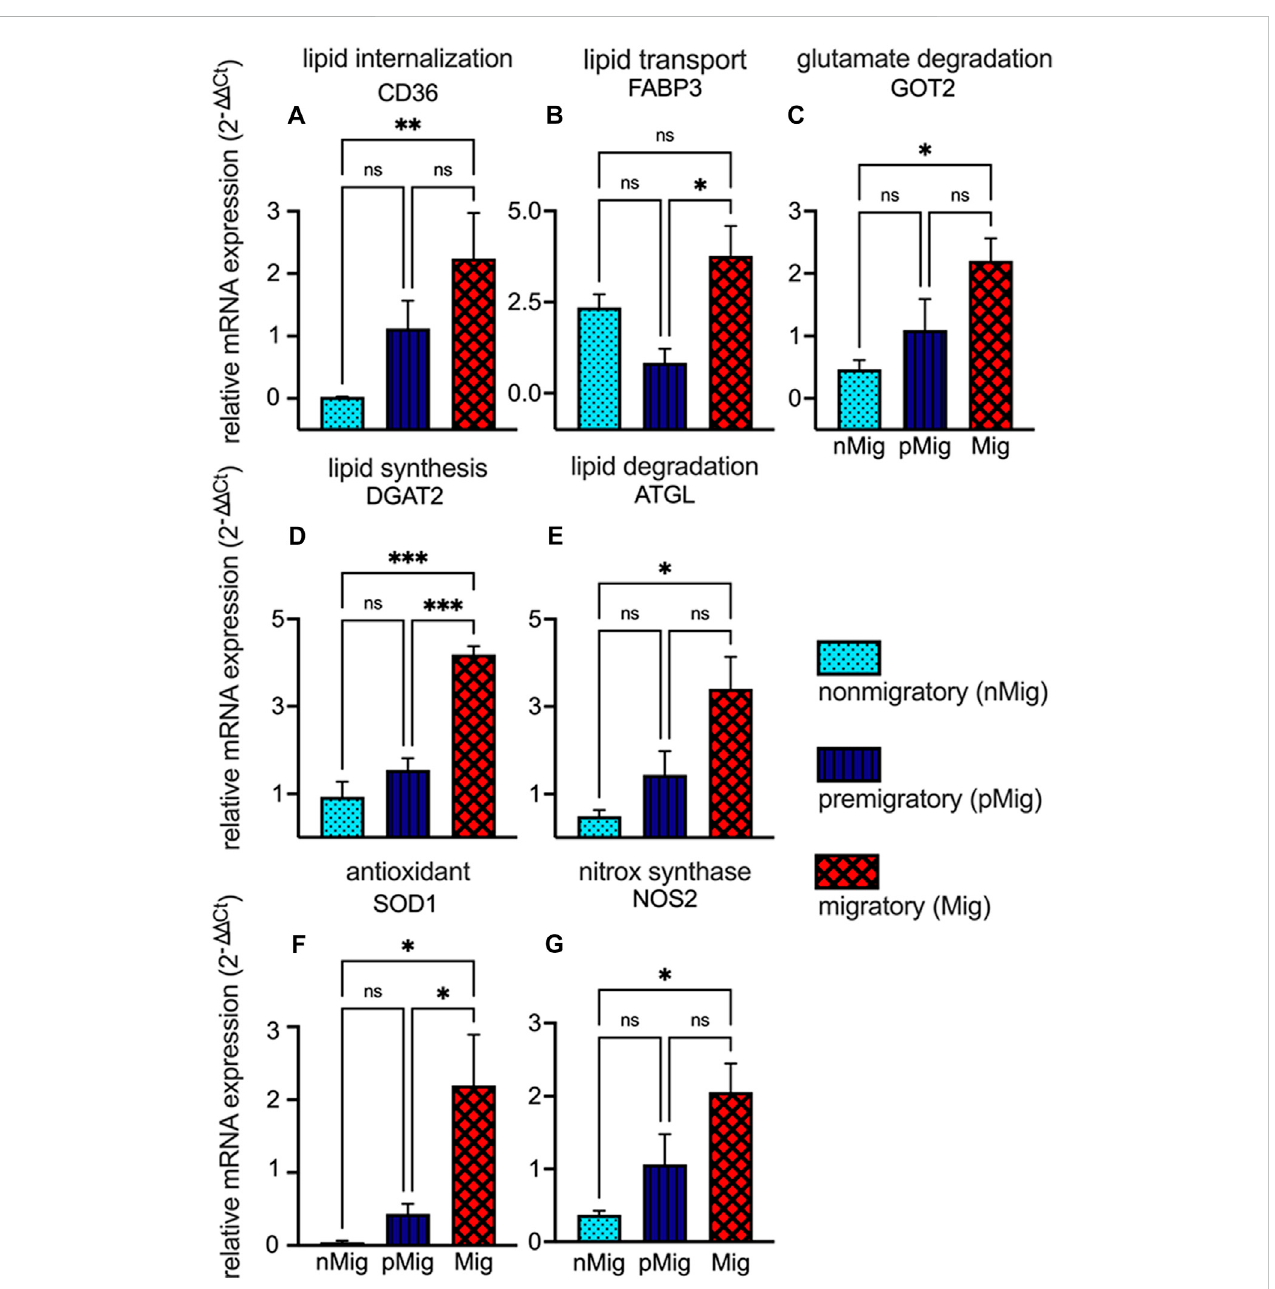
FIGURE 5 Changes in the relative expression of fatty acid transporters and antioxidant genes. The blood was collected from non-migratory ( nMig , cyan blue), pre- migratory ( pMig ,blue),andmigratory( Mig ,red)red-headedbuntings( n =6)placedunderSD/LDfor0,7,and28 days.RNAwasisolatedfrom8L:16D/14L:10D exposed birds erythrocytes using TRIzol (TRI) reagents. The fi rst strand of cDNA for isolated RNAwas synthesized byusing theFirst Strand cDNA Synthesis kit. The cDNA obtained was ampli fi ed using qRT-PCR. The RNA transcripts for different genes were quanti fi ed by SYBR Green method. Relative expression levels of fatty acid transporter genes CD36, FABP3, ATGL, DGAT2, and GOT2 have been shown in panels (A – E) . The expression levels of antioxidant genes SOD1 and NOS2 are shown in panels (F,G) . Expression levels of mRNA were normalized to β -actin levels using the 2 − ΔΔ CT method. Data are represented as mean±SEM.Asterisk(*)overthelineonthebarindicatesasigni fi cantdifferencebetween nMig , pMig ,and Mig statesofbuntings(* p < 0.05,Tukey ’